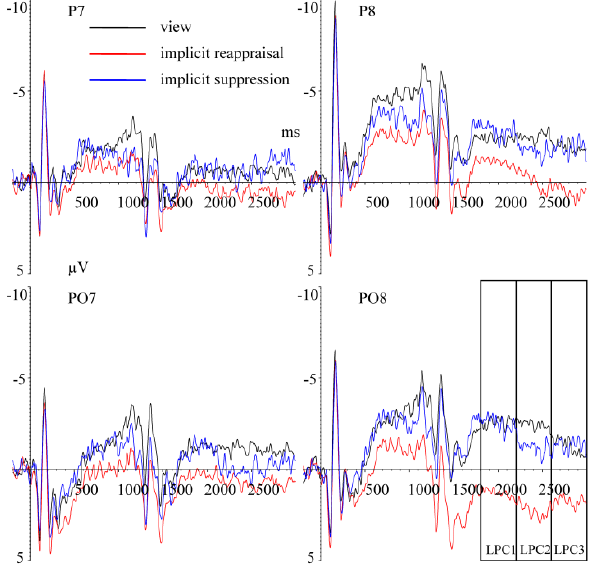
Figure 7. Grand average ERPs of T-LPC component for view (black lines), implicit reappraisal (red lines), and implicit suppression (blue lines), under implicit fear priming condition, recorded at P7, P8, PO7, and PO8.